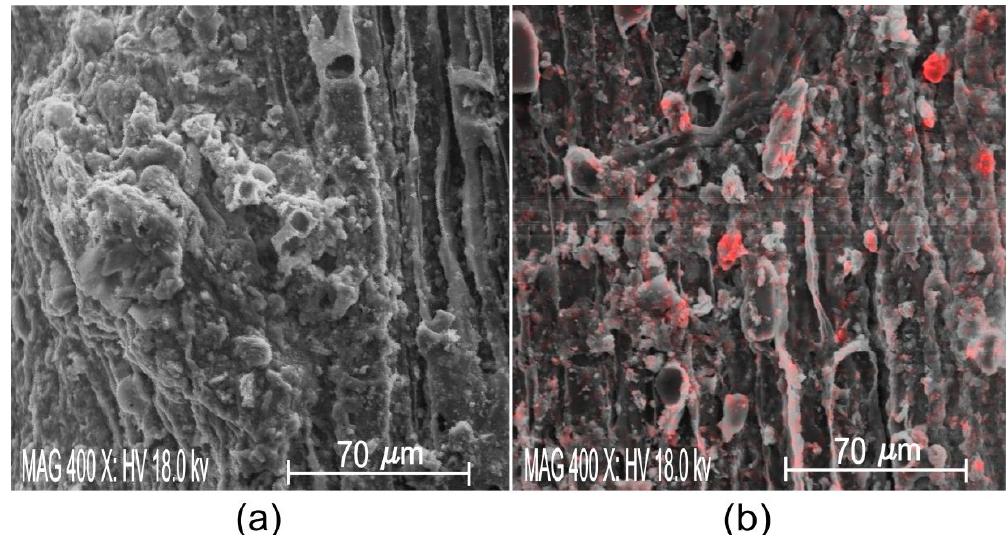
Figure 8. Olive stone waste surface morphology as recorded by scanning electron microscopy: ( a ) before metal-ion biosorption, ( b ) after Ni(II) biosorption. Visible nickel appears in